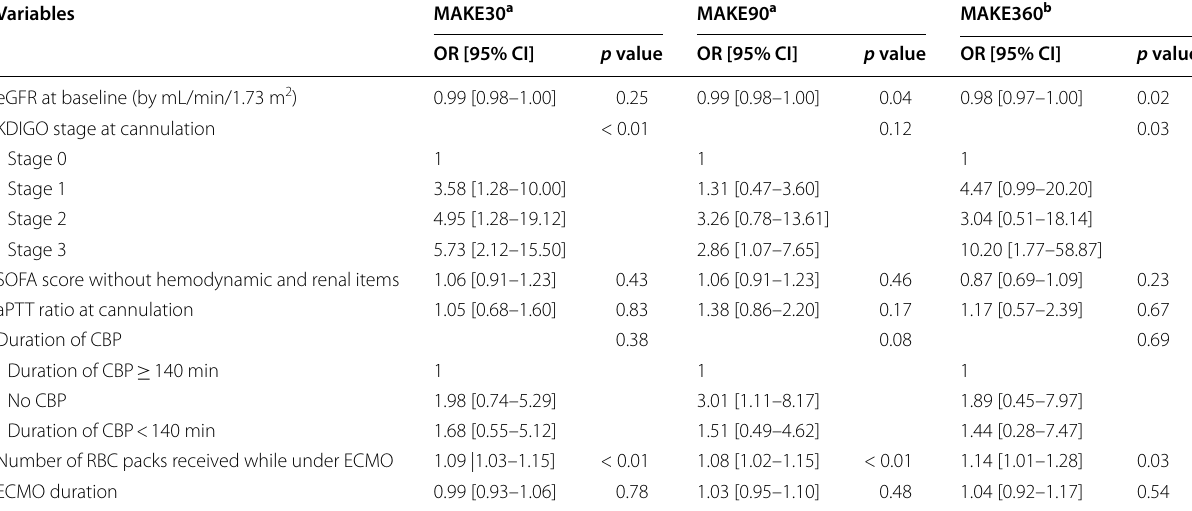
Table 2 Multivariate logistic regression analysis: independent predictors of major adverse kidney events (MAKE) at day 30, at day 60, and at day